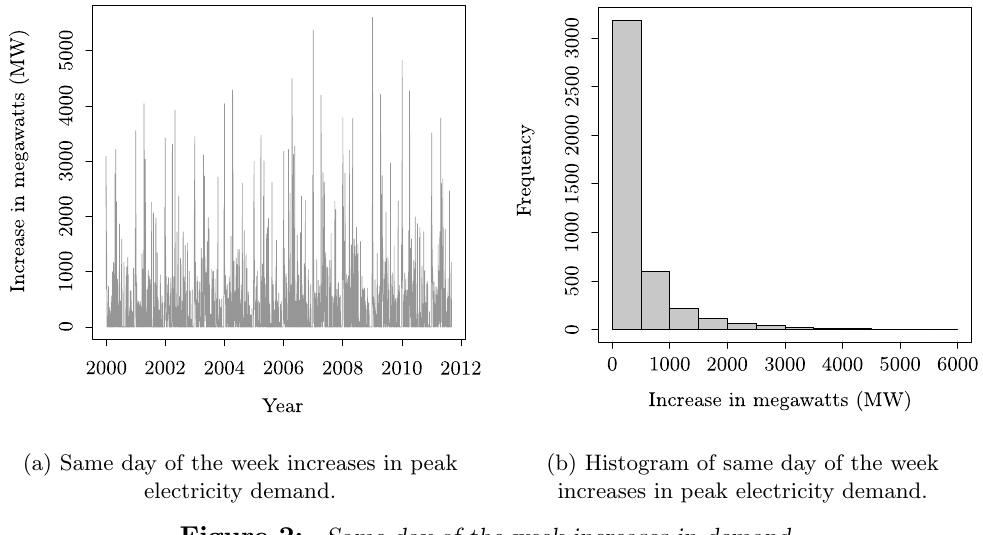
Figure 2: Same day of the week increases in